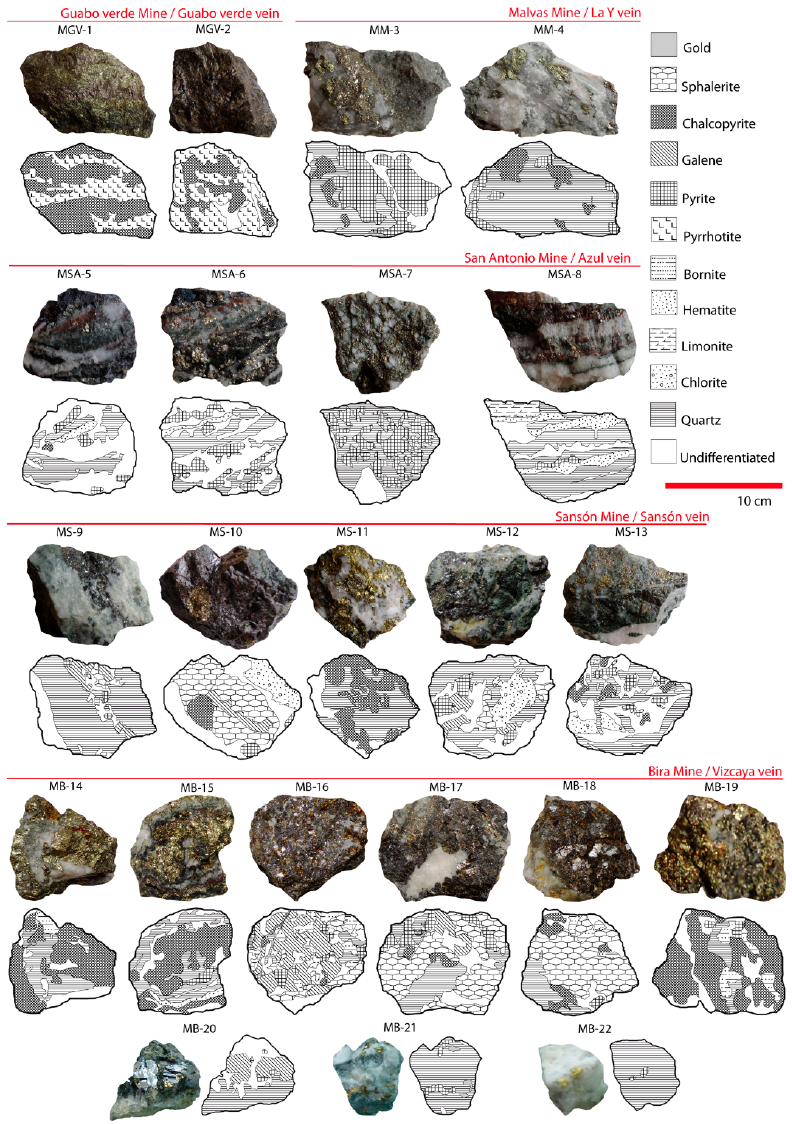
Figure 4. Ore samples (22) of the studied intermediate-sulfidation epithermal deposit shown in Figure 1. Photographs of hand specimens and sketches with the principal identified ore minerals (11 mineral species are shown).